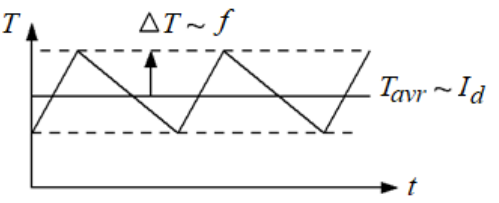
Figure 4. Instant and average temperature of conductors.